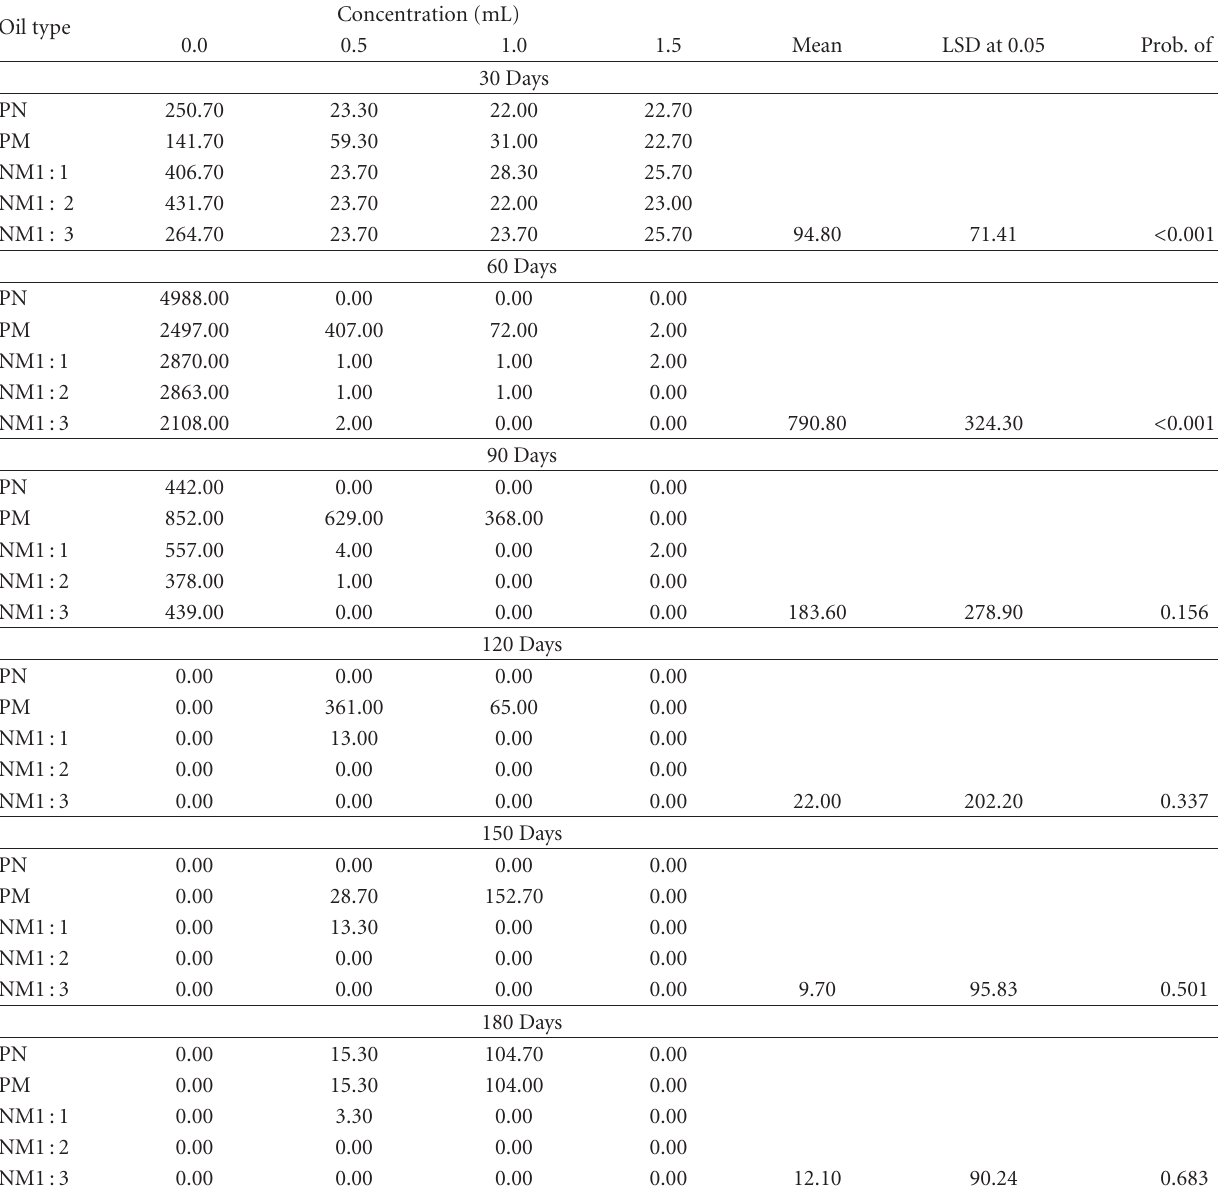
Table 2: Interaction e ff ects of oil types and various concentrations of the oils on total weevil population of cowpea after di ff erent storage